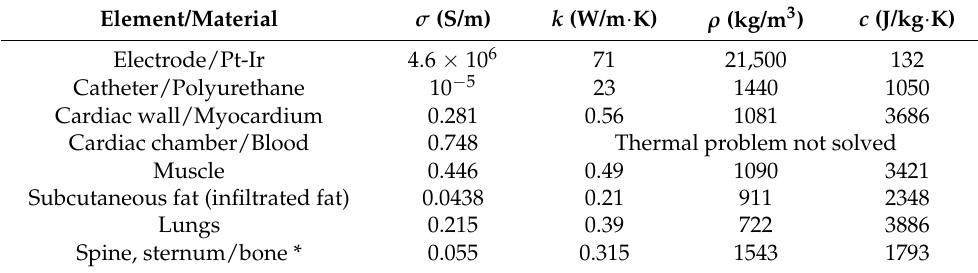
Figure 3. Anterior ( A ) and posterior ( B ) views of the patient’s torso including the elements in- cluded in the computational model.